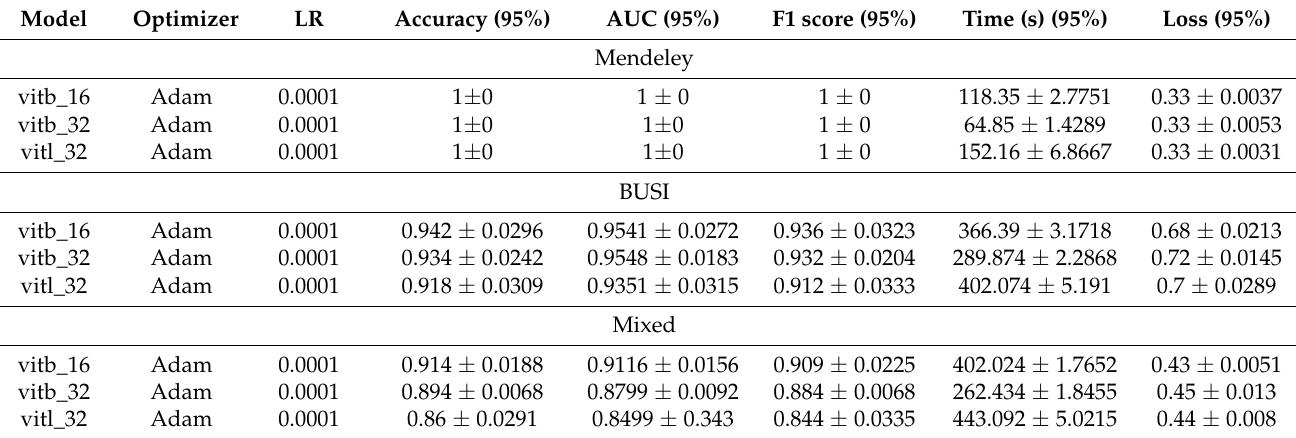
Table 5. Performance of conventional transfer-learning-based ViT models. BUSI, breast ultrasound image dataset; LR, learning rate; s, seconds; AUC, area under receiver operating curve.